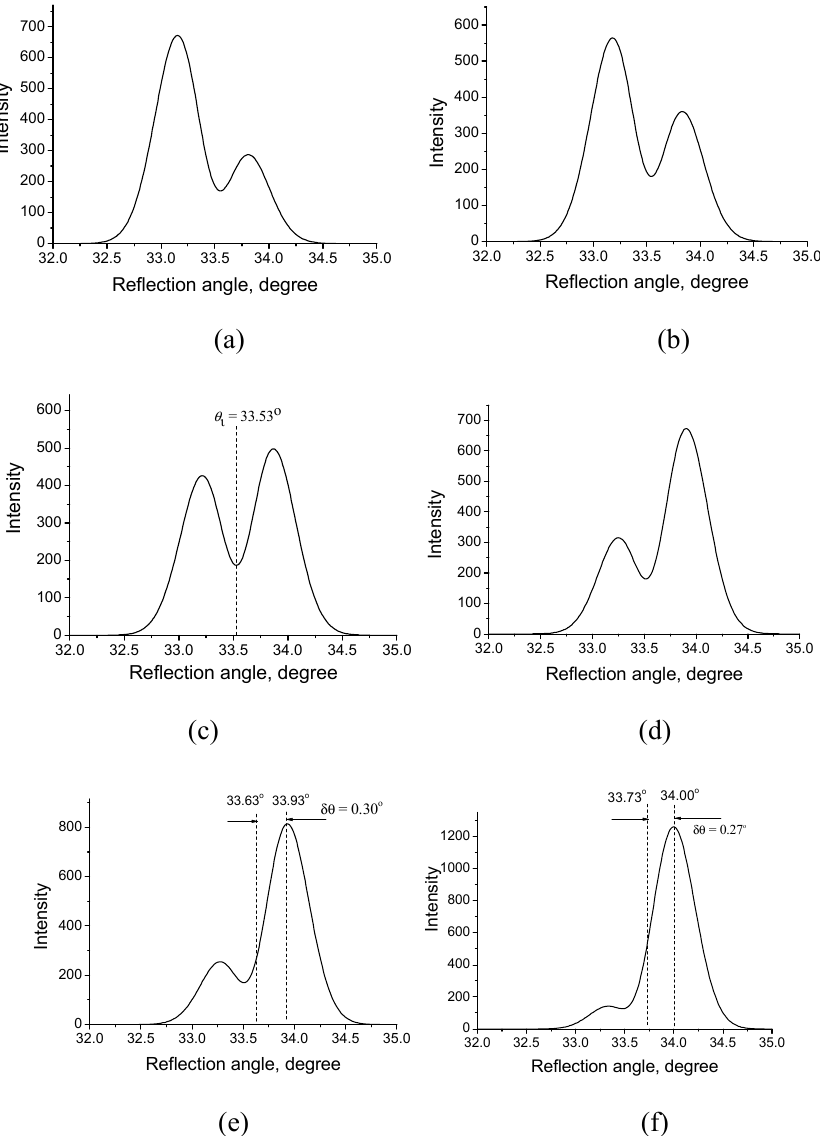
Figure 6. Calculated intensity profiles as function of the reflection angle. FWHM = 26.64 µ m. ( a ) θ i = 33.43 ◦ ; ( b ) θ i = 33.47 ◦ ; ( c ) θ i = 33.53 ◦ ; ( d ) θ i = 33.59 ◦ ; ( e ) θ i = 33.63 ◦ ; ( f ) θ i = 33.73 ◦